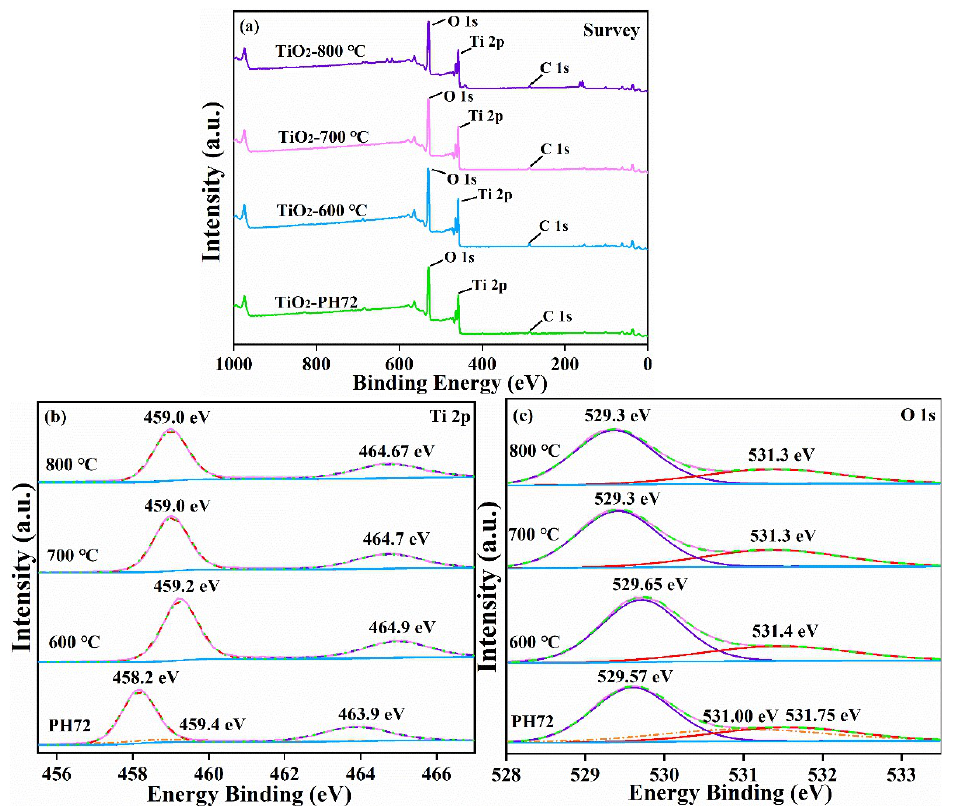
Figure 6. XPS spectra of the TiO 2 fiber obtained after calcination at different temperatures and plasma treatments: ( a ) survey spectra, ( b ) Ti 2p spectra, and ( c ) O 1s spectra.